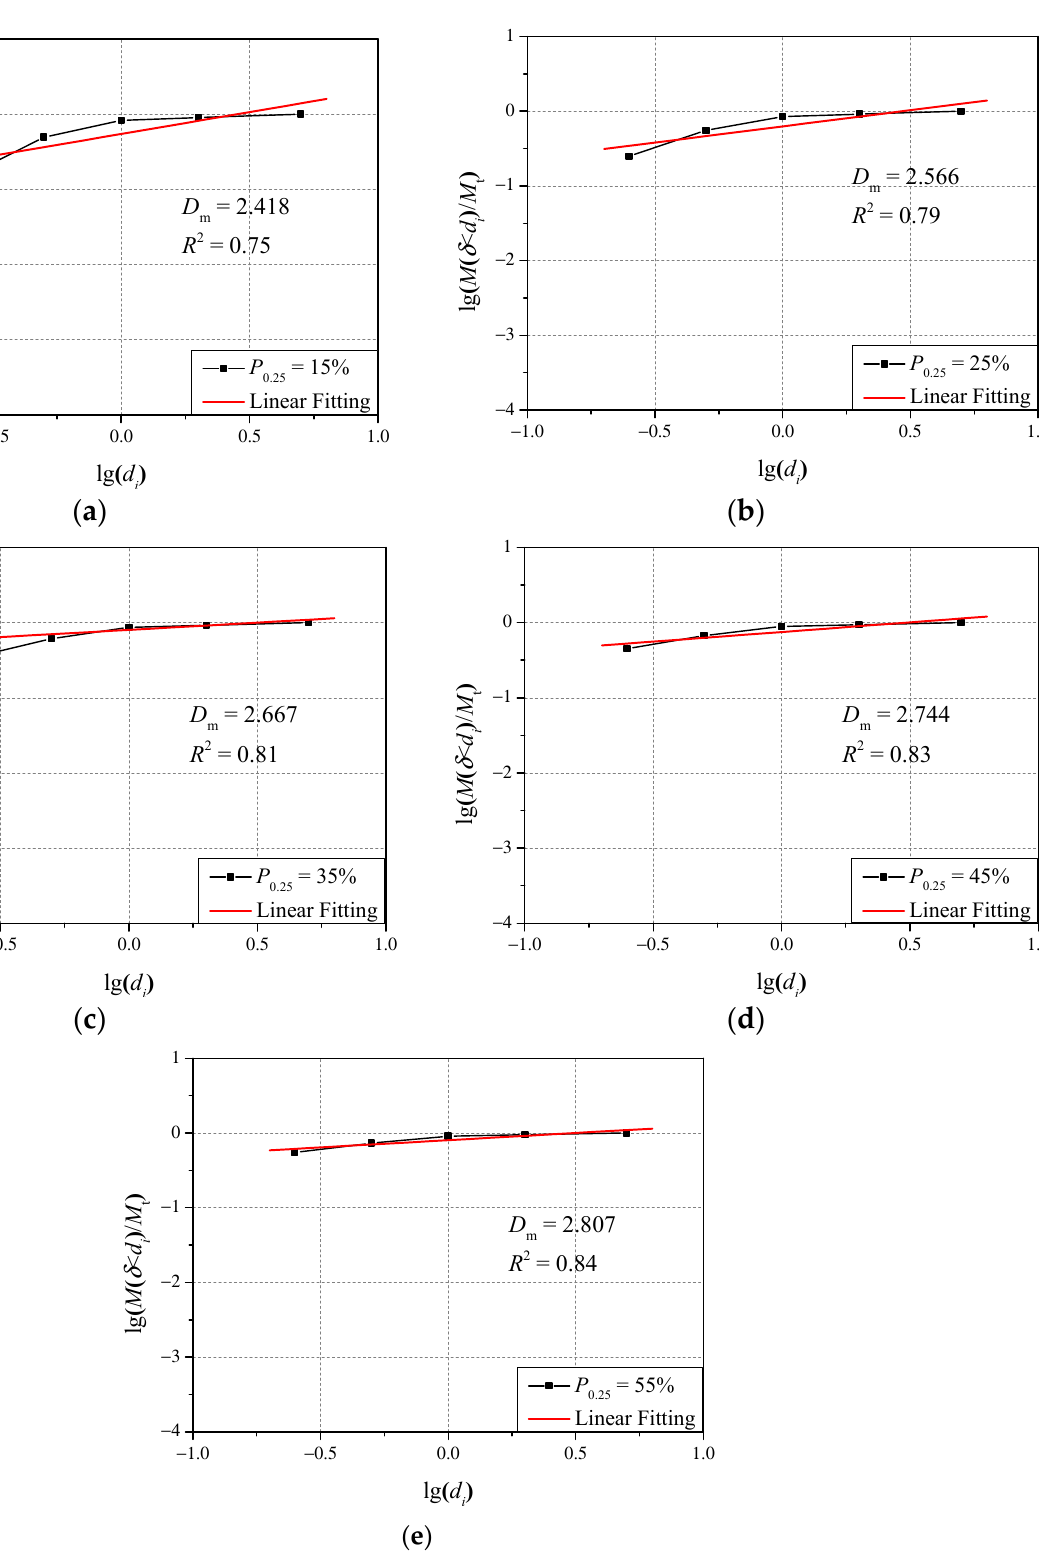
Figure 3. Determination of fractal dimensions of calcareous sand with different gradation: ( a ) content of particles smaller than 0.25 mm is 15%; ( b ) content of particles smaller than 0.25 mm is 25%; ( c ) content of particles smaller than 0.25 mm is 35%; ( d ) content of particles smaller than 0.25 mm is 45%; ( e ) content of particles smaller than 0.25 mm is